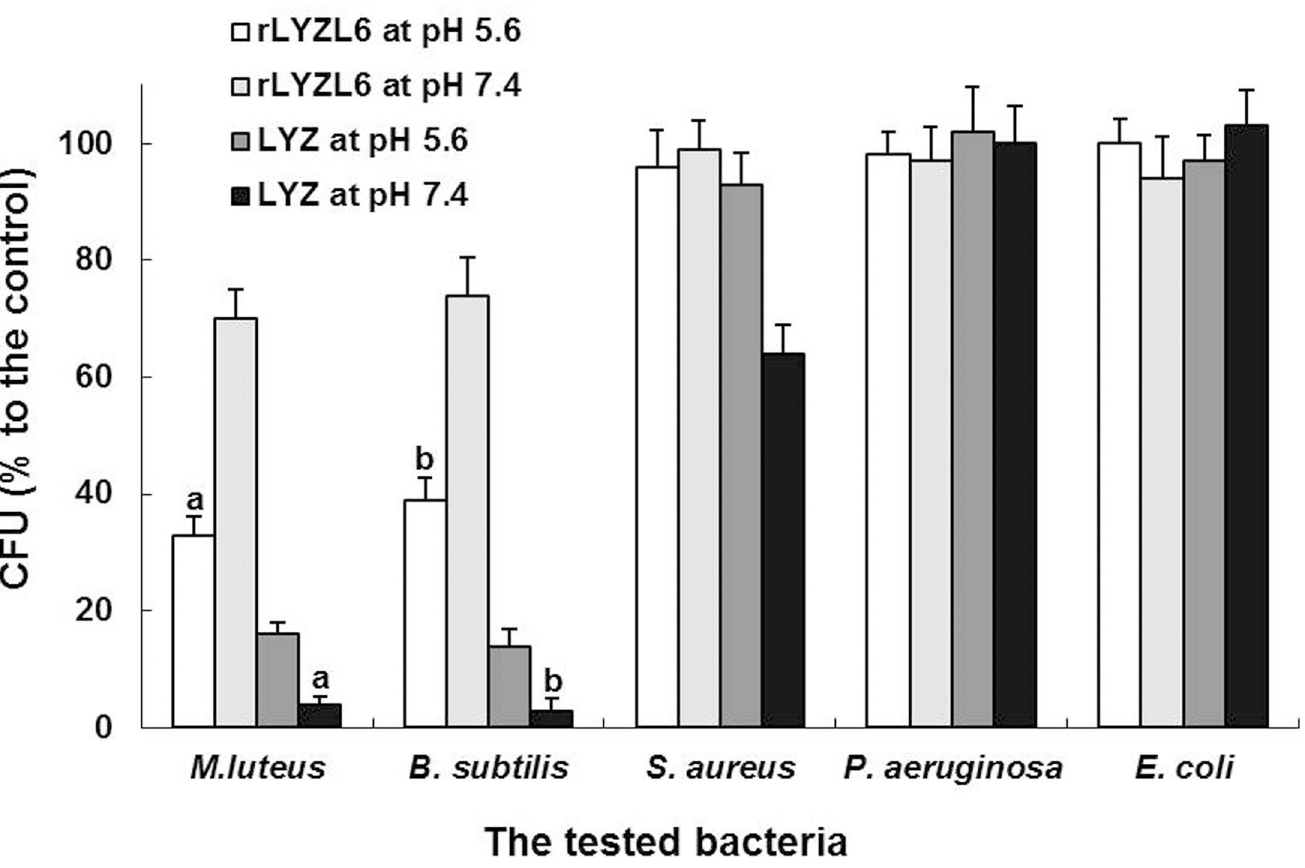
Fig 6. Bacteriolytic activities of rLYZL6 or LYZ under different conditions. The results are presentedas the percentageof the control incubated without protein. The rLYZL6 protein showedhigh bacteriolytic activities against M . lysodeikticus , and B . subtilis . The growth inhibitioncaused by rLYZL6 decreased significantly after transferringto a high pH ( P < 0.001). The rLYZL6 protein exhibitedweaker bacteriolytic activities than LYZ against the sensitive strains ( P < 0.05). The letters (a and b) were used to indicatethe comparisons.